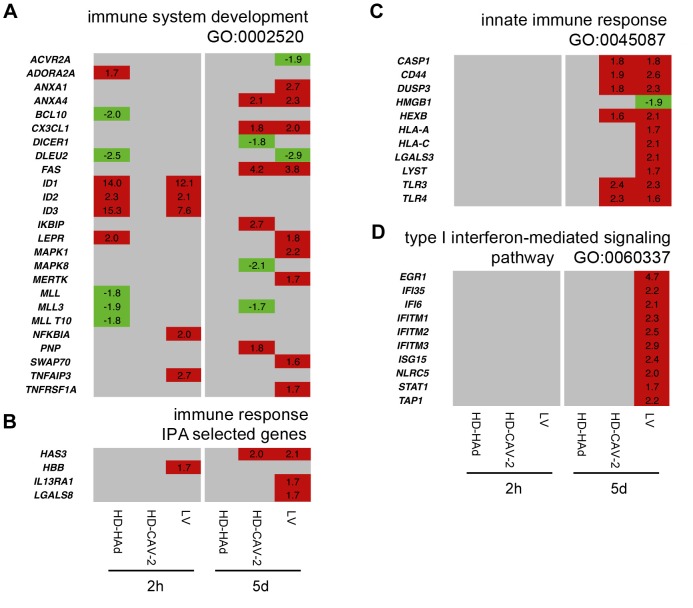
Comparative analysis of immune response gene expression profiles induced by HD-HAd, HD-CAV-2 and LV.(a–d) Heat maps of genes identified by combined IPA and GO analysis with a threshold set at p≤0.01, clustering in immune response categories. The relative gene modulation fold change values are indicated; in red, upregulated genes, in green, downregulated, and in grey, genes with unmodified expression with respect to mock. Of note is the LV dependent activation of the IFN subgroup (GO: 0060337) and the LV and HD-CAV-2 induced activation of the TLRs and HA related signaling pathway components at 5 days posttransduction.